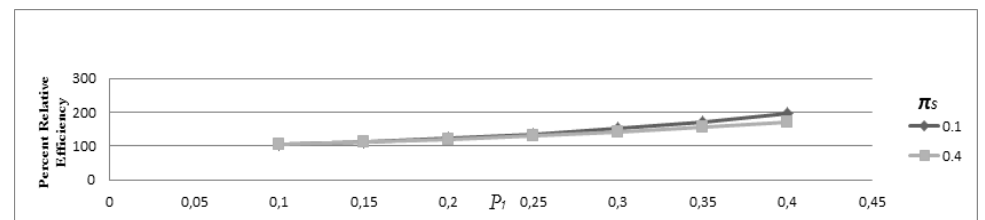
π with respect to the suggested c